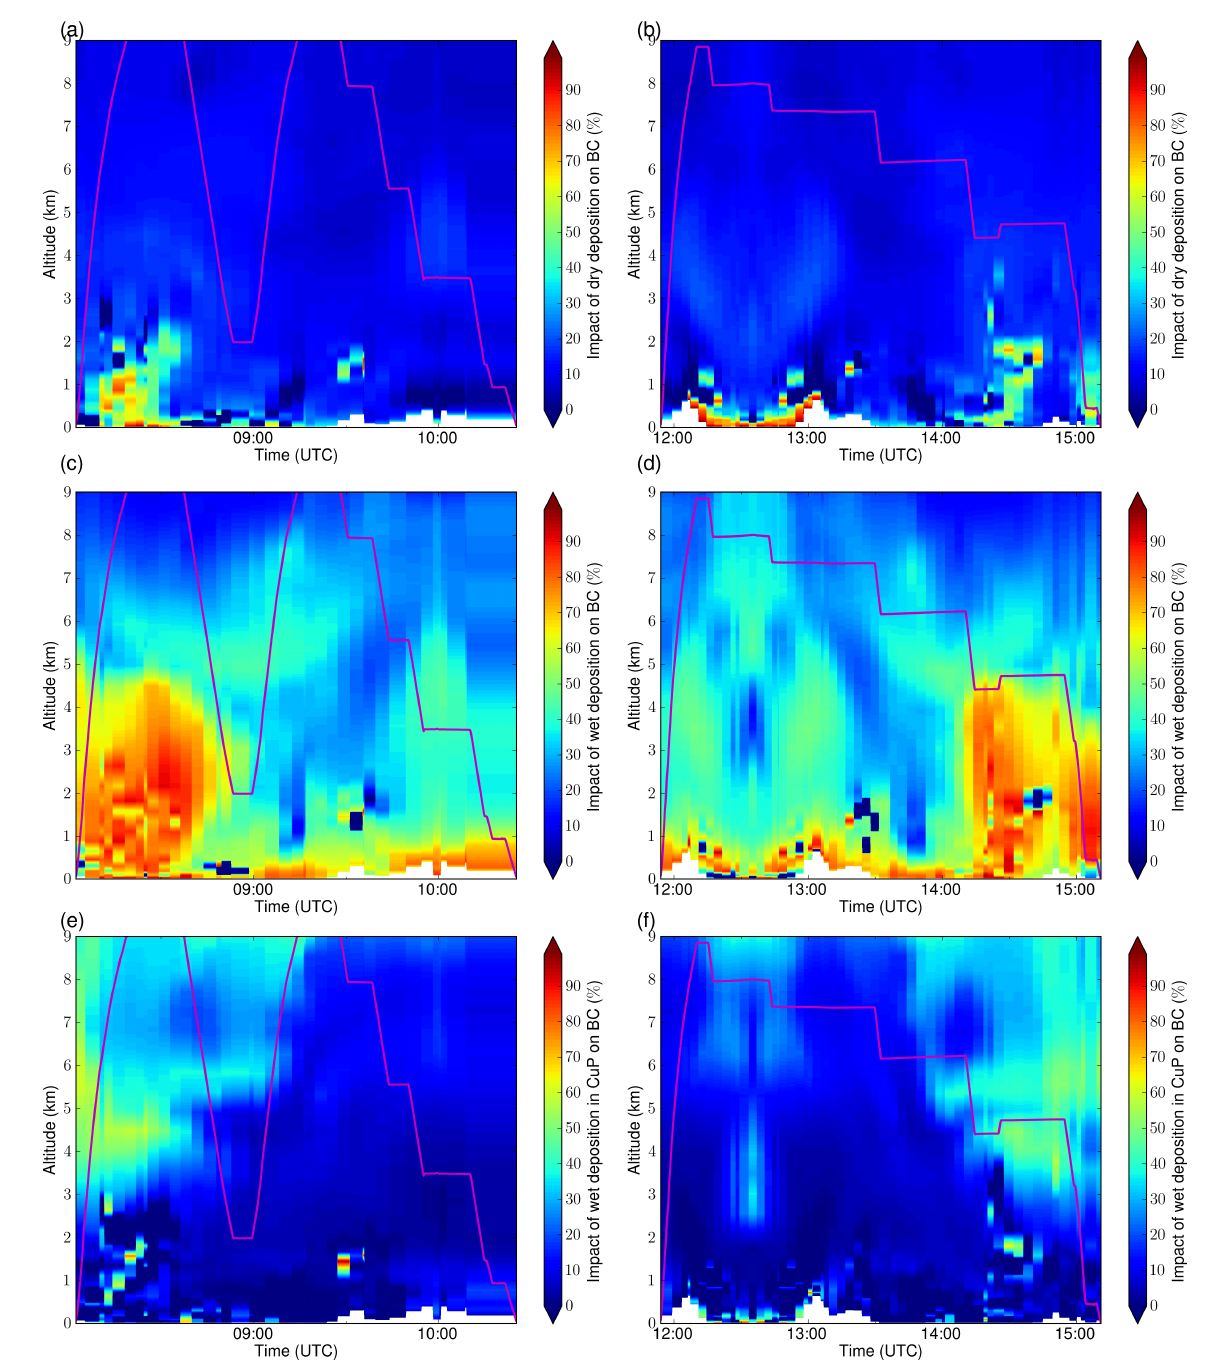
Figure 11. Time–altitude cross sections of the relative contributions (%) of (a, b) dry deposition, (c, d) wet deposition in grid-resolved clouds and (e, f) wet deposition in parameterized cumulus clouds to the BC mass mixing ratio along flight tracks 17a (in panels a , c and e ) and 17b (in panels b , d and f ). The altitude of the two flights is indicated in magenta in each panel.